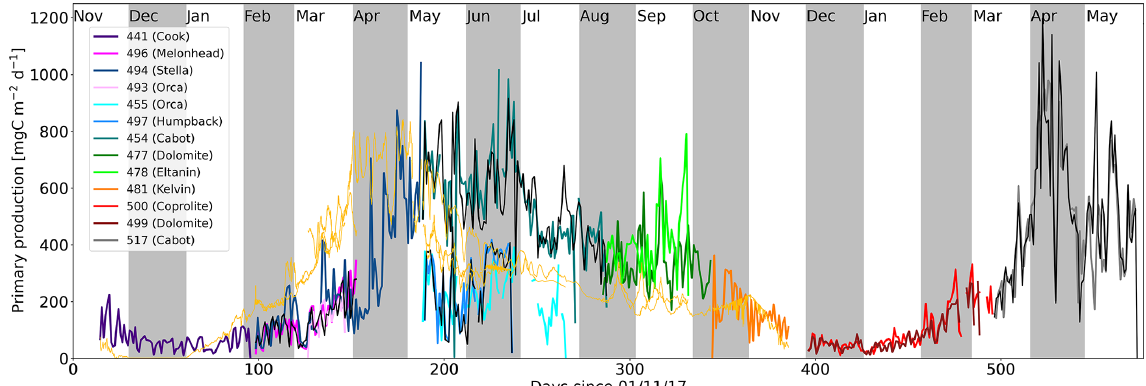
Figure 9. Daily integrated net primary production rate estimates from all gliders deployed in the AlterEco programme (see Table 1). Coloured traces represent each glider mission (matching those used in Fig. 1) and show the net primary production estimates derived from the SEO- based PAR method. Where in situ PAR sensors were available, a corresponding black trace for that glider mission is also shown. The thin orange trace shows the net primary production extracted from v4.2 of the ESA Ocean Colour Climate Change Initiative (OC-CCI) NPP product for each glider where